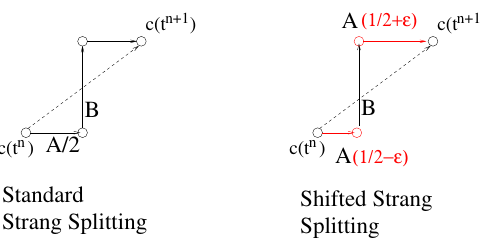
Figure 1. Standard Strang splitting and shifted Strang splitting